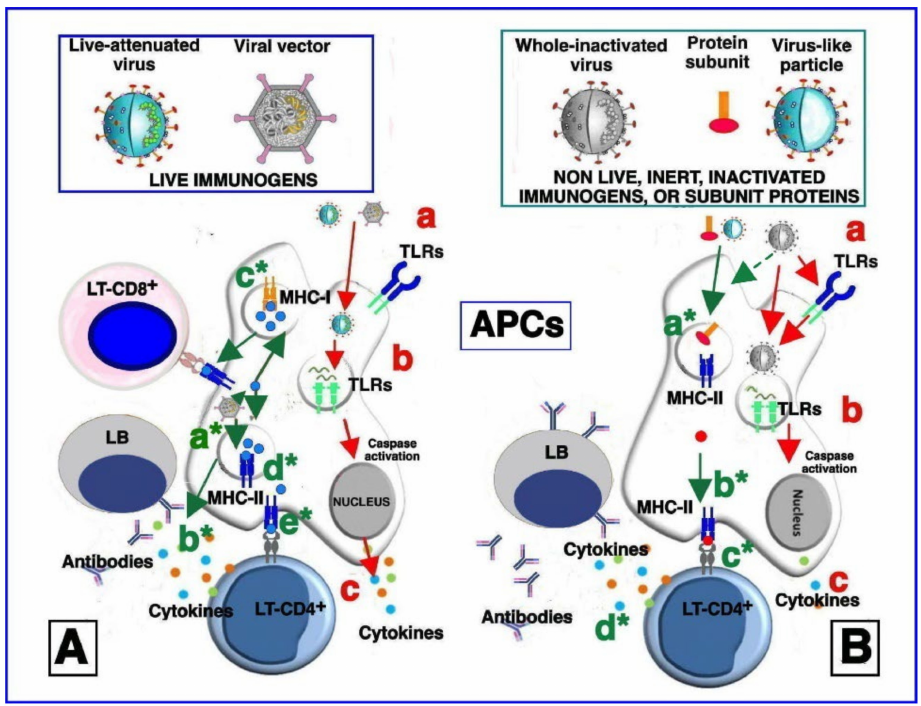
Figure 2. Simplified model of vaccine stimulation of the immune system. ( A ) Immune stimulation by live-attenuated viruses and/or vectored viral immunogens. After immunization, live-attenuated and vectored viral particles are endocytosed by antigen-presenting cells (APCs). The